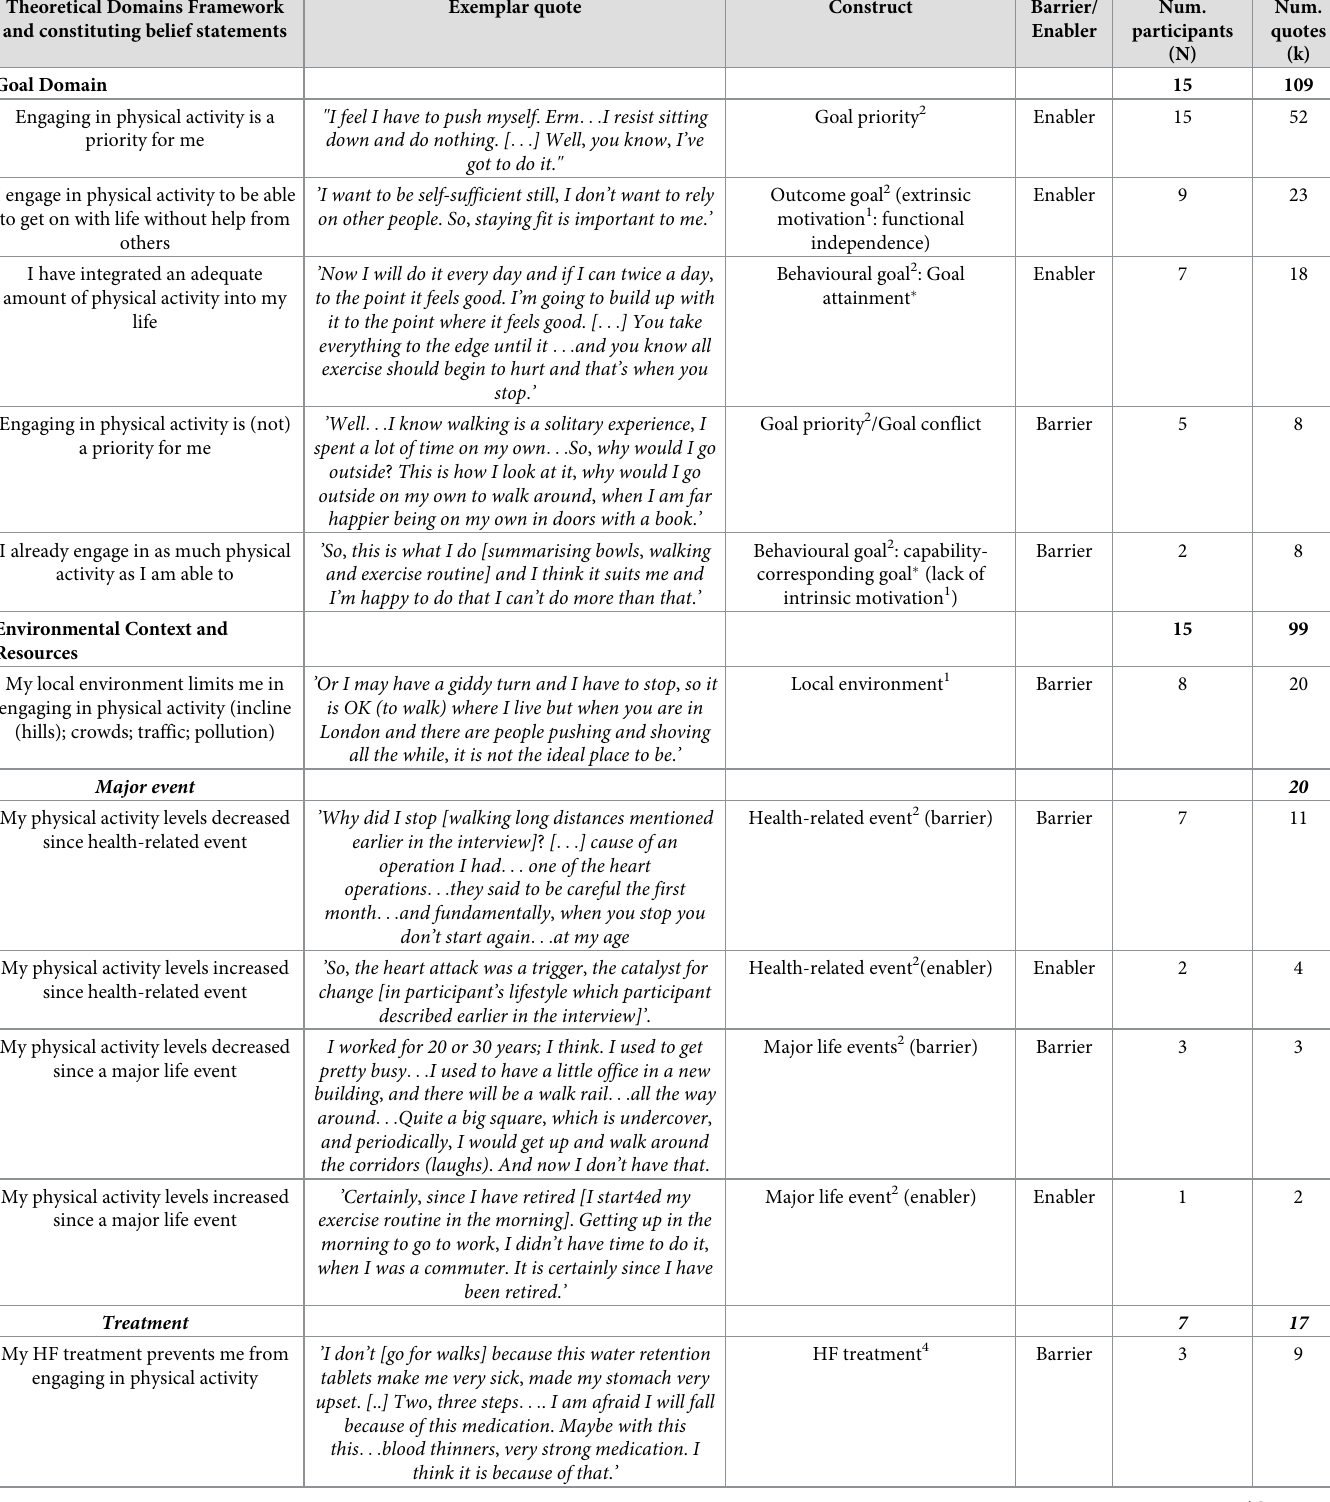
Table 2. The TDF domains, constituting belief statements, corresponding constructs and their relevance to physical activity in HF. Theoretical Domains Framework and constituting belief